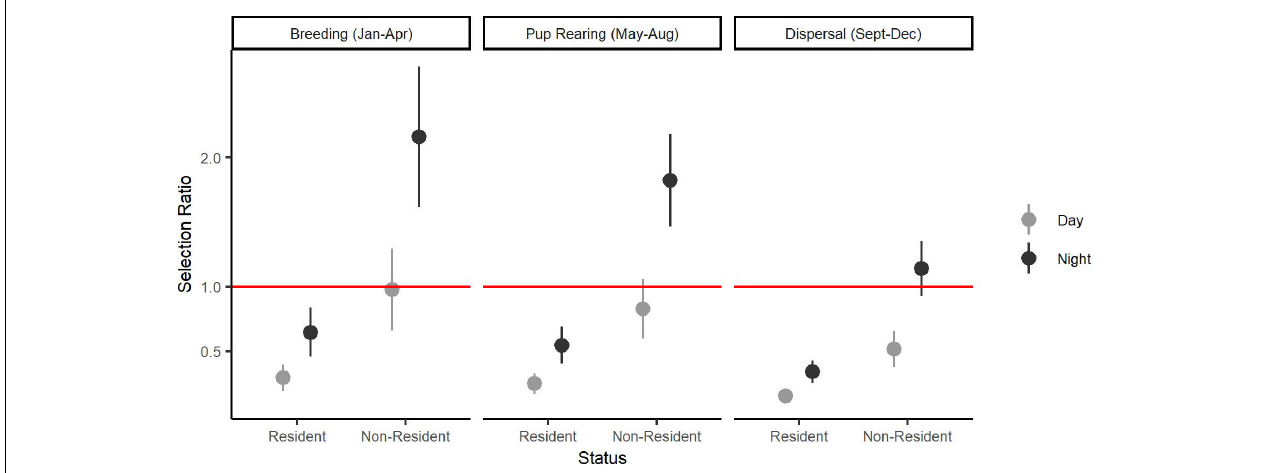
FIGURE 3 | Individual and temporal variation in selection for Housing based on a Step Selection Function conducted on 14 coyotes with GPS collars in the Greater Toronto Area, Canada from 2012 to 2017. Selection Ratio on the y-axis shows how likely an animal will select Housing relative to Other Developed land use classes. Error bars represent standard error around the estimate of the fixed effects. The red line indicates when Housing areas are equally as likely to be selected as Other Developed